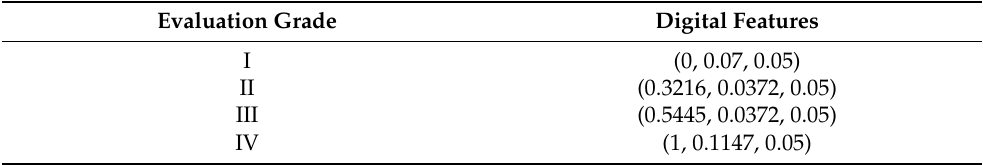
Table 8. Standard cloud digital features of four risk assessment